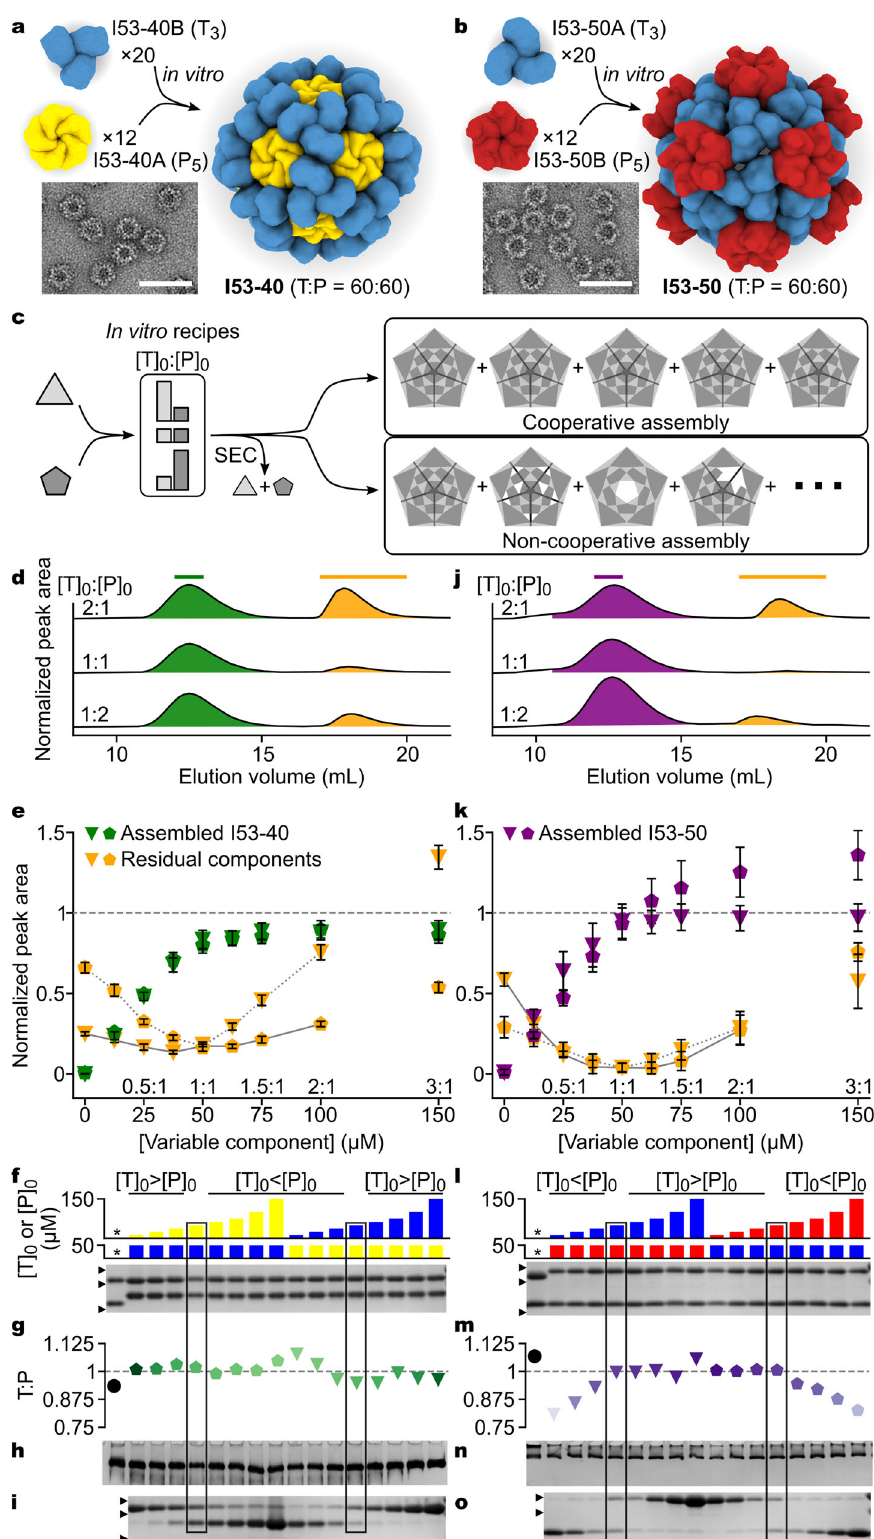
(Fig. 1d, j and Supplementary Fig. 1a – d), hinting at the absence of small partial